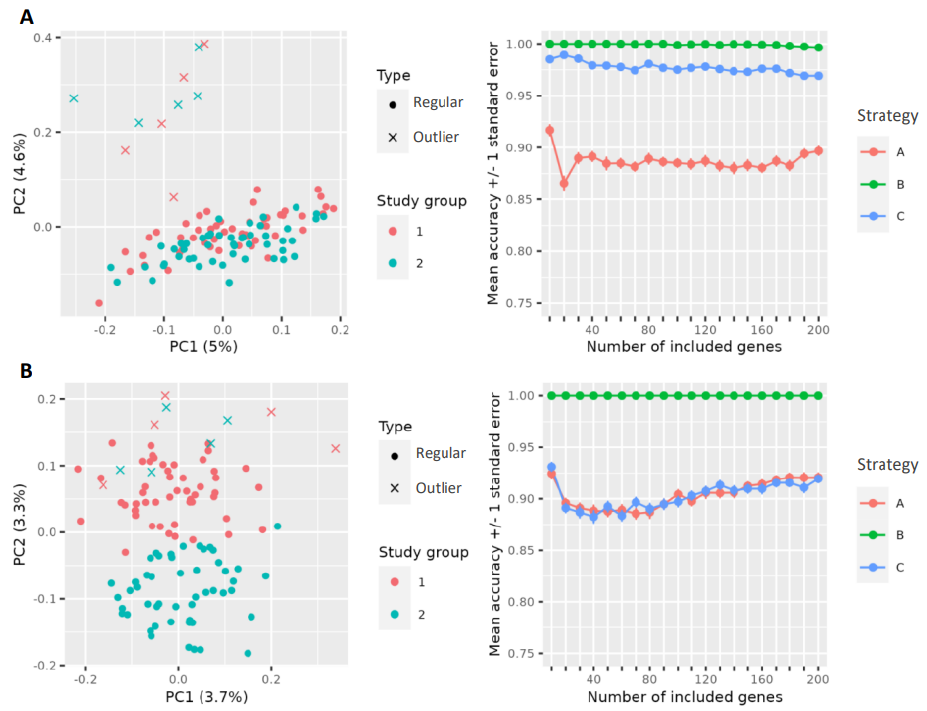
Figure 6. Two exemplary simulated datasets with associated classification outcomes for different scenarios regarding the handling of outliers represented by mean accuracies +/ − standard errors. For the simulation data displayed in plot ( A ), seven outliers in total were identified with the bootstrap– bagplot approach and removed in strategy C (blue line), respectively. For the simulation displayed in the plot below ( B ), only one sample was detected and removed for strategy